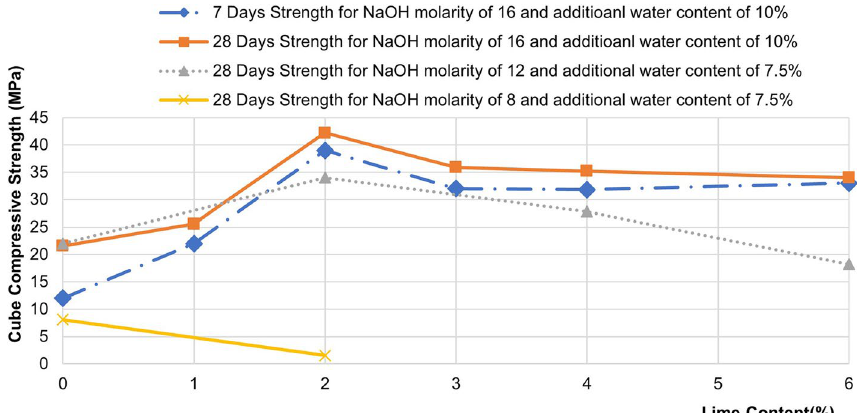
Fig. 3 The effect of lime content on 7 days and 28 days compressive strength for different NaOH